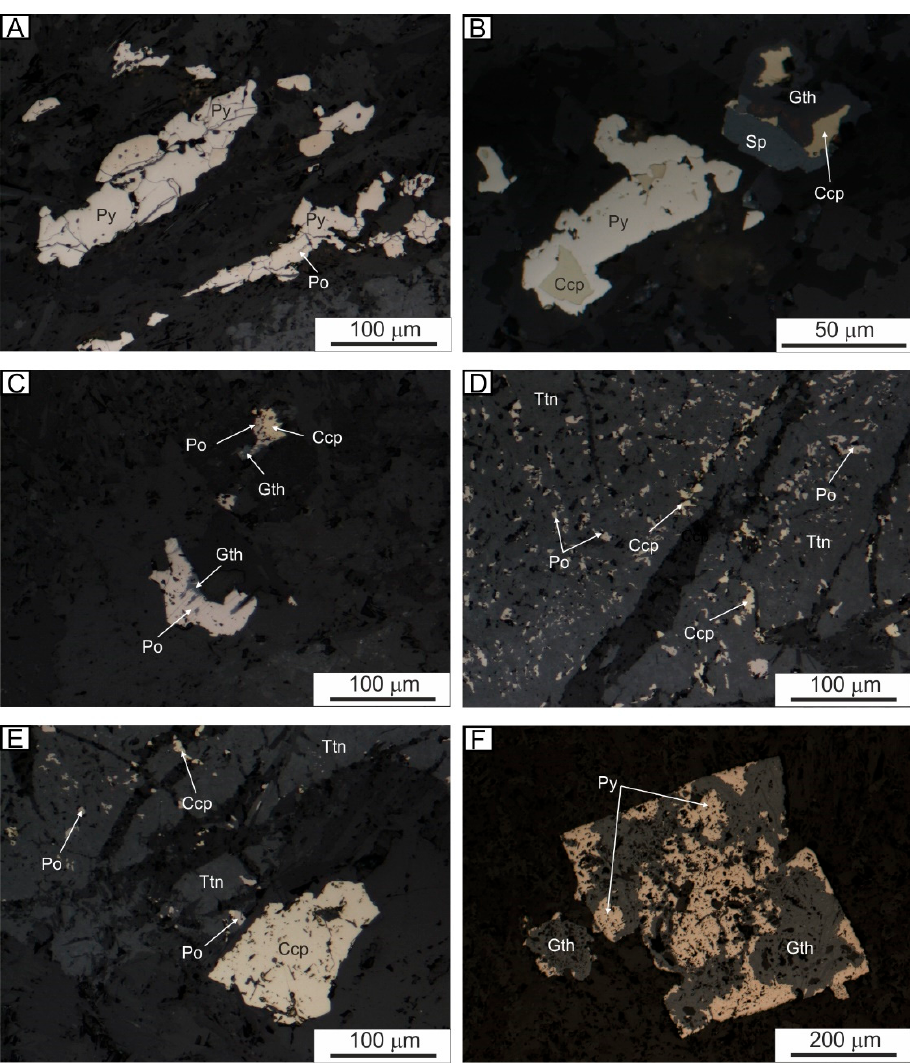
Figure 5. Sulphide associations within the metadolerites. ( A , B ) Pyrite aggregates along the D1–S1 foliation plane. Within the pyrites small blebs of pyrrhotite are common. Sample Dau1411 (site DAUST2), parallel nicols; ( B ) pyrite, chalcopyrite and sphalerite association Chalcopyrite is partly replaced by goethite. Sample Dau1411 (site DAUST2), parallel nicols; ( C ) large pyrrhotite and pyrrhotite-chalcopyrite aggregates. All sulphides are partly replaced by goethite. Sample Dau5304 (site DAUST5), parallel nicols; ( D ) Titanite pseudomorph after Ti-rich magnetite. Within titanite numerous small blebs of pyrrhotite and chalcopyrite. Sample Dau5607 (site DAUST5), parallel